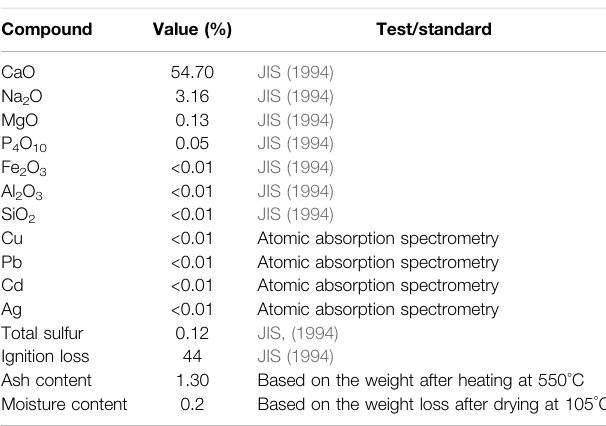
TABLE 2 | Chemical composition analysis results of SSP.